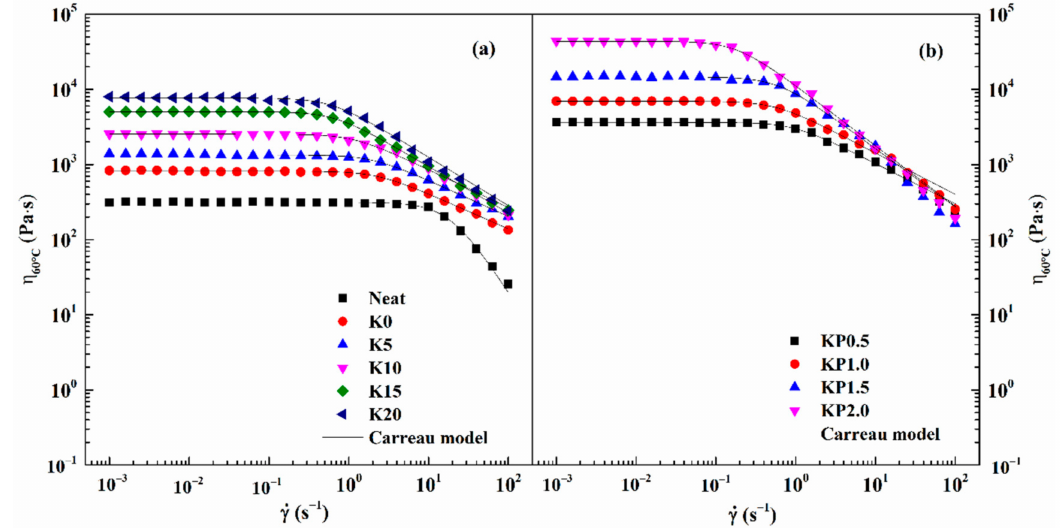
Figure 5. Carreau model fitting curves for all samples at 60 ◦ C: ( a ) SBS/OSDOA-modified asphalts; ( b ) composite modified